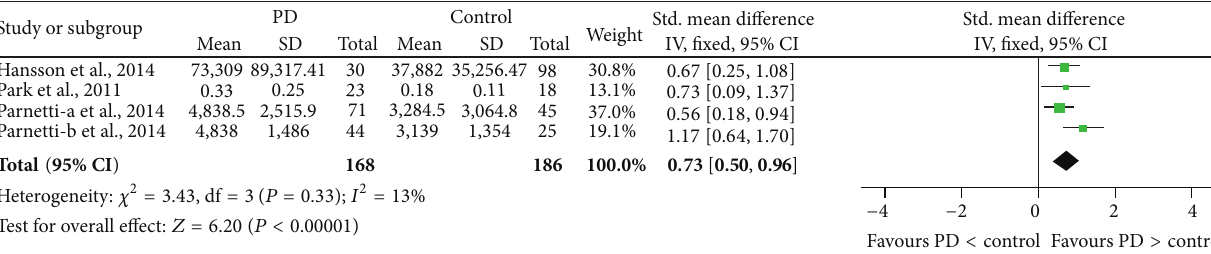
Figure 7: Forest plot of CSF 𝛼 -syn oligomers levels in PD compared with control.